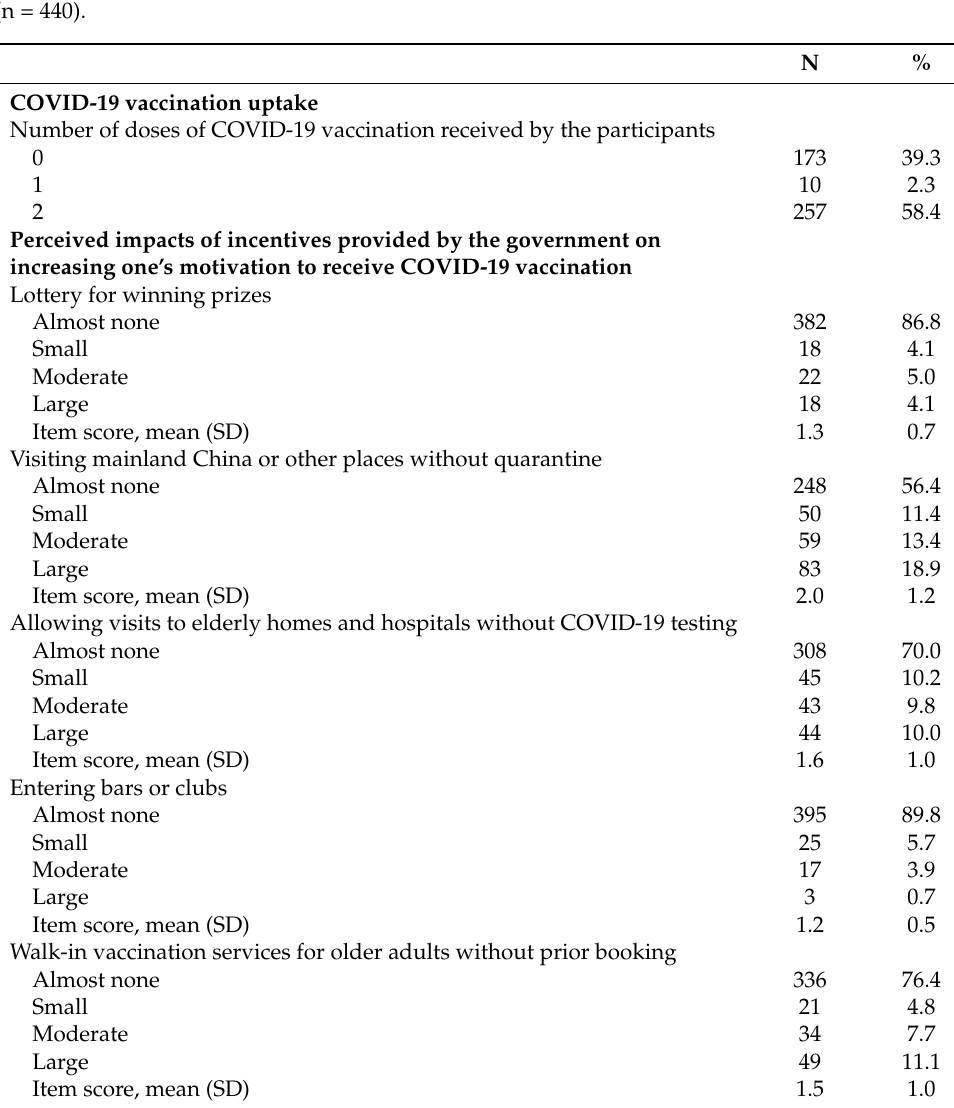
Table 2. Descriptive statistics of COVID-19 vaccination uptake and independent variables of interest (n = 440).